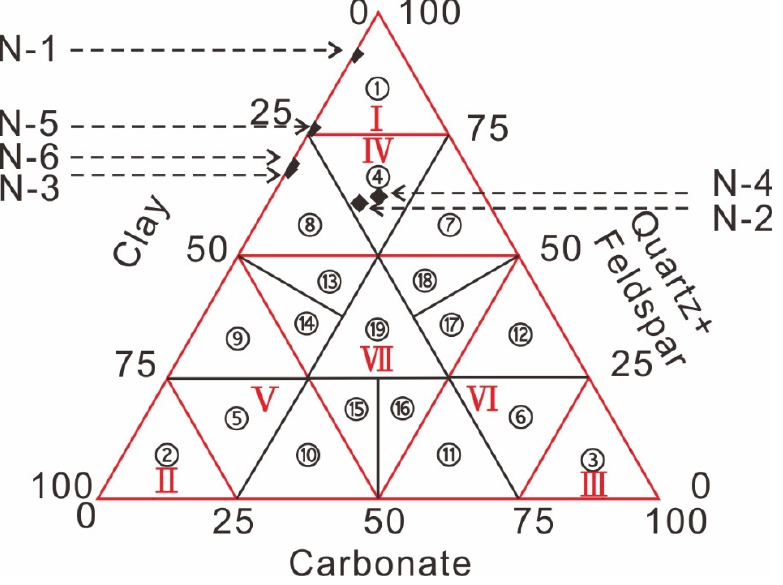
Figure 2. Scheme of shale lithofacies (modified after [53]) and the plotted results of studied sam- ples. Ⅰ siliceous rock, Ⅱ claystone, Ⅲ carbonate rock/dolostone, Ⅳ siliceous shale, Ⅴ argillaceous shale, Ⅵ calcareous shale, Ⅶ mixed shale. ① siliceous rock, ② claystone, ③ carbonate rock/dolostone, ④ feldspar/quartz siliceous shale, ⑤ argillaceous shale, ⑥ calcareous shale, ⑦ calcareous feldspar/quartz siliceous shale, ⑧ argillaceous feldspar/quartz siliceous shale, ⑨ sili- ceous argillaceous shale, ⑩ calcareous argillaceous shale, ⑪ argillaceous calcareous shale, ⑫ si- liceous calcareous shale, ⑬ argillaceous-siliceous mixed shale, ⑭ siliceous-argillaceous mixed shale, ⑮ calcareous-argillaceous mixed shale, ⑯ argillaceous-calcareous mixed shale, ⑰ sili- ceous-calcareous mixed shale, ⑱ calcareous-siliceous mixed shale, ⑲ mixed shale.